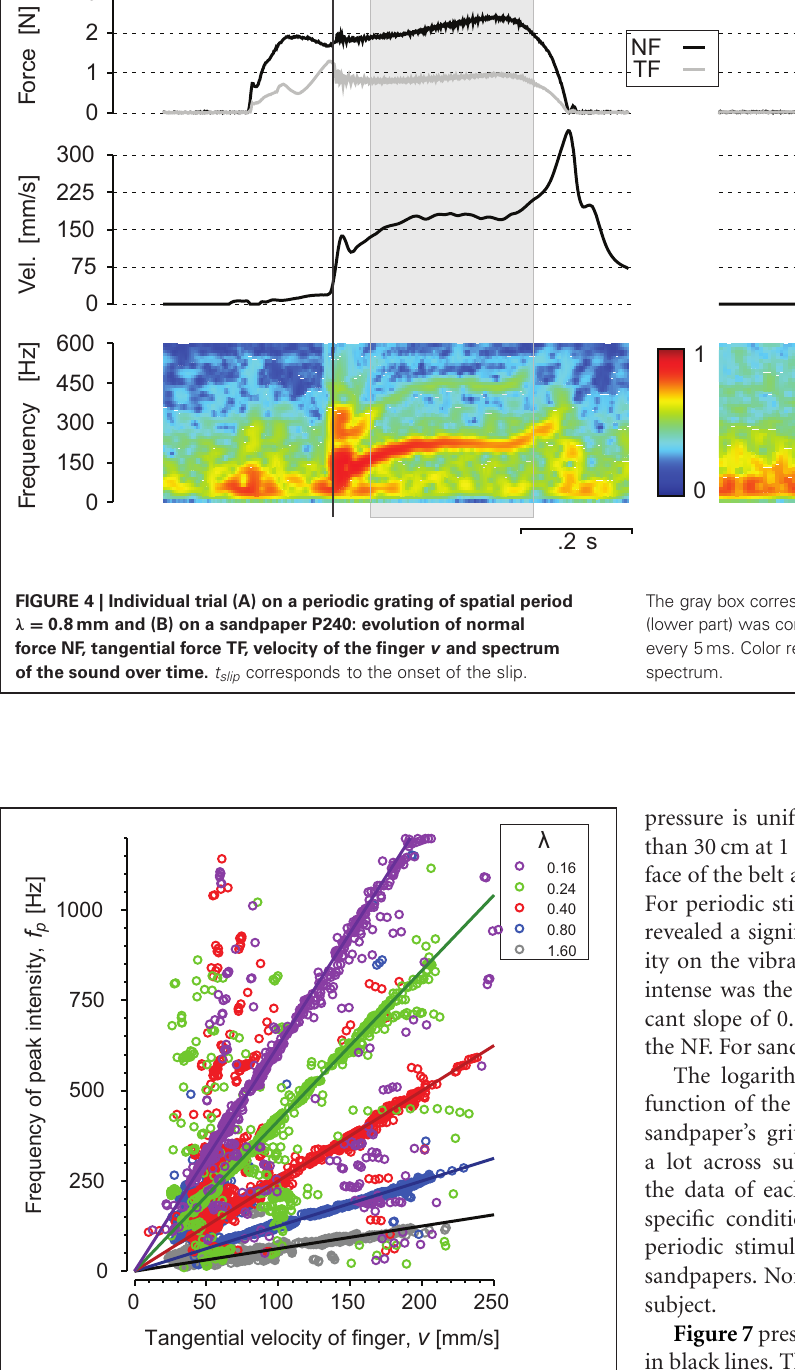
FIGURE 5 | Periodic stimuli: relationship between the speed of the finger and the frequency of the peak intensity of the spectrum for one individual subject. Each stimulus spatial period λ ) is represented by a different color: λ = 0 . 16mm (magenta), λ = 0 . 24mm (green), λ = 0 . 4mm (red), λ = 0 . 8mm (blue) and λ = 1 . 6mm (gray). Continuous lines are theoretical slopes ( f = 1 λ · v